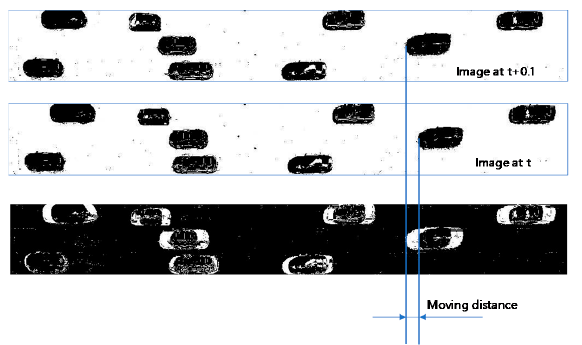
Figure 16. A description of the background subtraction methodology .